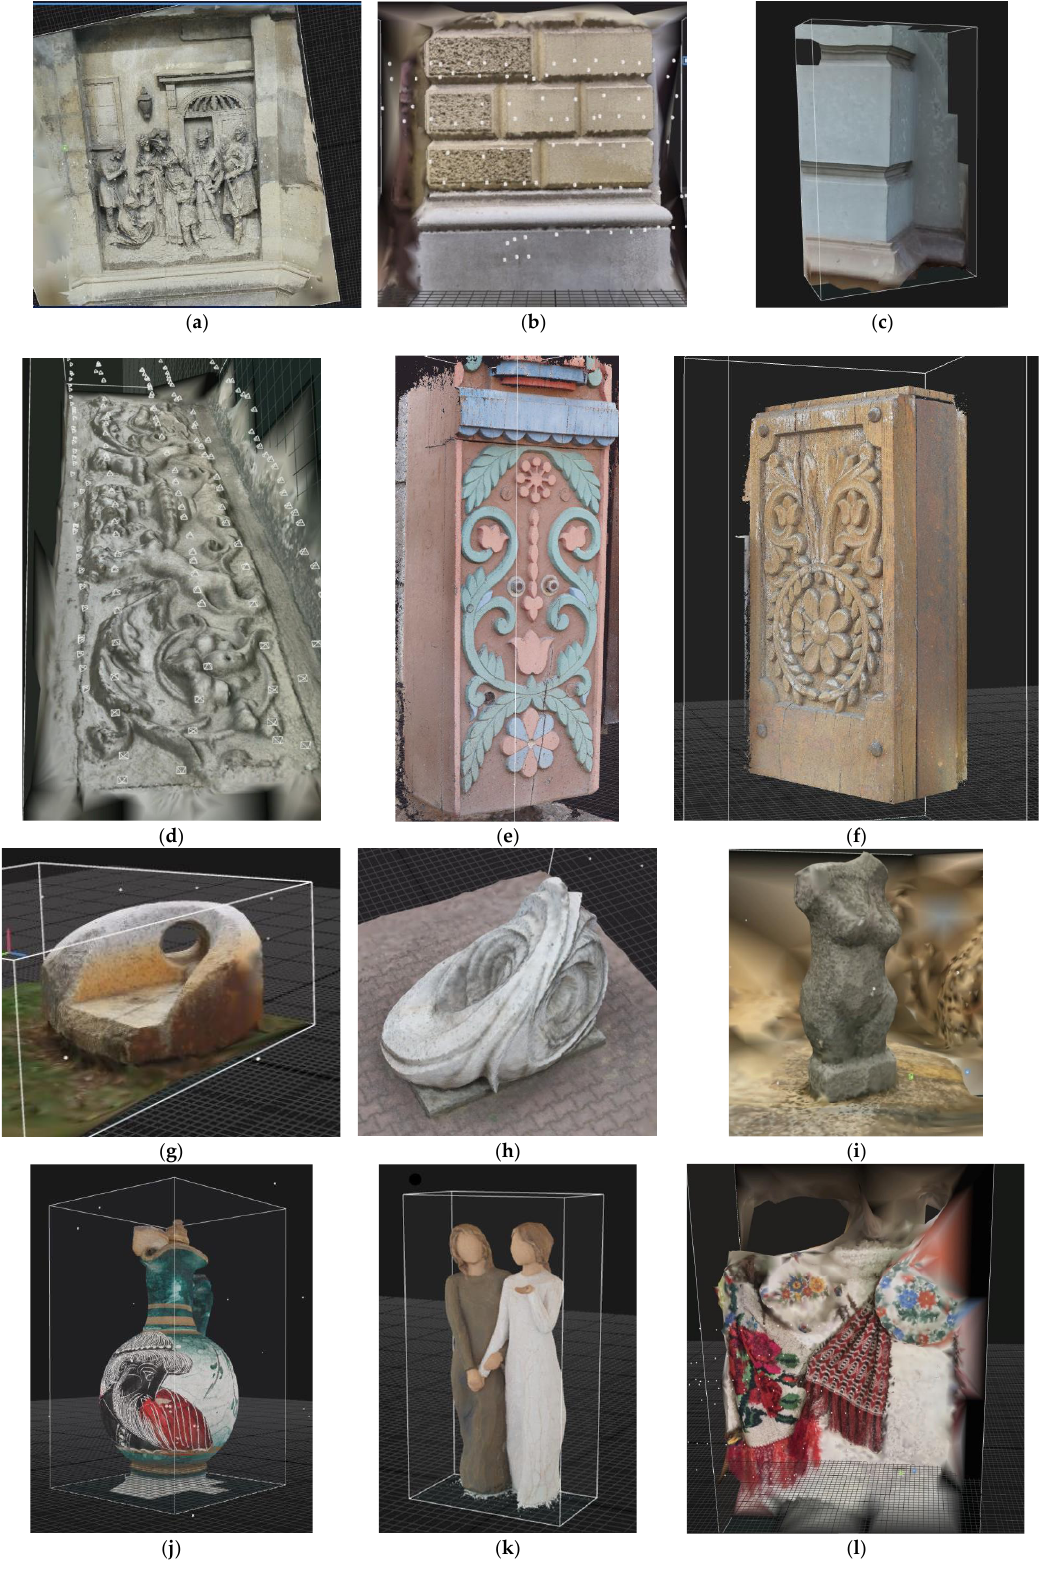
Figure 6. 3D models of art and architecture elements executed by students, independently.( a ), ( b ), ( c ), ( d ), ( l ), uniform surfaces without important protuberances, compact volumetrics, ( e ), ( f ), ( g ), ( h ), ( i ), ( j ), ( k ), with